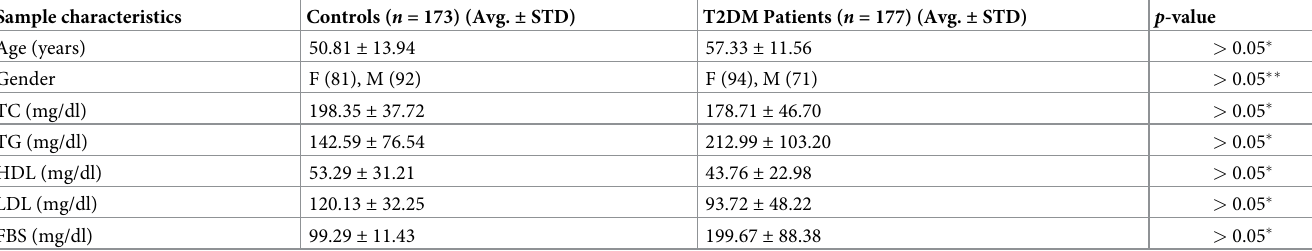
HDL, high-density lipoprotein; LDL, low-density lipoprotein; TC, total cholesterol; TG, triglycerides; FBS, fasting blood sugar; F, female; M, male. � and �� refer to the p -value resulted from t-test and chi-square test, respectively ( p -value is significant if < 0.05). Some people have missing data as indicated in S1 Table.